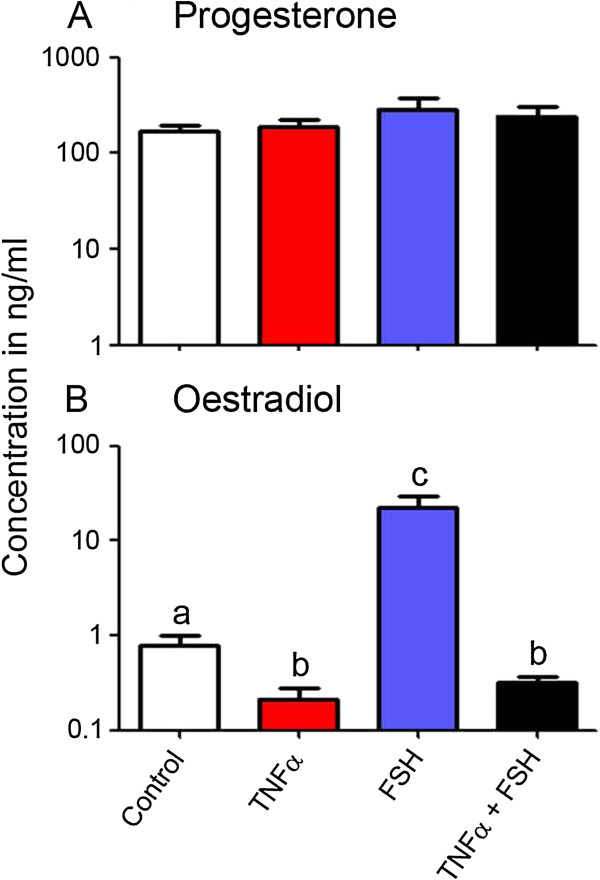
Concentrations of hormones from granulosa cells cultured for microarray analyses. Oestradiol (A) and progesterone (B) measured in media from cells cultured in the presence or absence of 0.33 ng/ml FSH and 10 ng/ml TNFα (n = 4 each). The axes are logarithmically scaled. Mean concentrations of oestradiol ± SEM in ng/ml for the different treatments were: 0.8 ± 0.2 (control), 0.2 ± 0.1 (TNFα), 22.4 ± 6.7 (FSH) and 0.3 ± 0.1 (TNFα + FSH). Corresponding values for progesterone were: 167 ± 29 (control), 187 ± 40 (TNFα), 289 ± 91 (FSH) and 243 ± 63 (TNFα + FSH). Significantly different values (two-way ANOVA with Fisher’s LSD post hoc test, P < 0.05) are indicated by different letters.